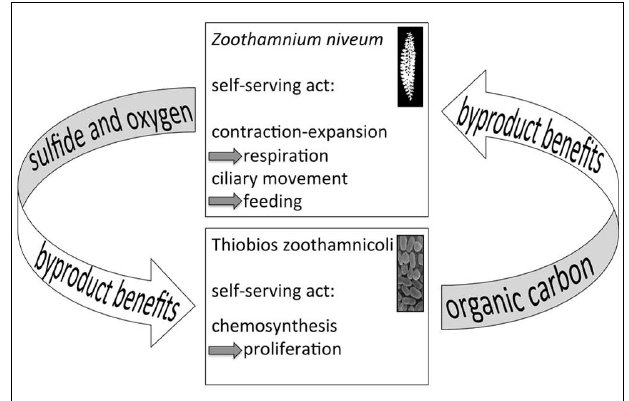
FIGURE 11 | Diagram of the putative byproduct mutualism. The host’s behaviors to contract and expand and the ciliary movement are self-serving acts to gain access to oxygen for respiration and for feeding, respectively. As a byproduct, sulfide and oxygen is provided to the symbiont. On the other hand, the symbiont fixes carbon as a self-serving act to grow and as a byproduct nourishes the